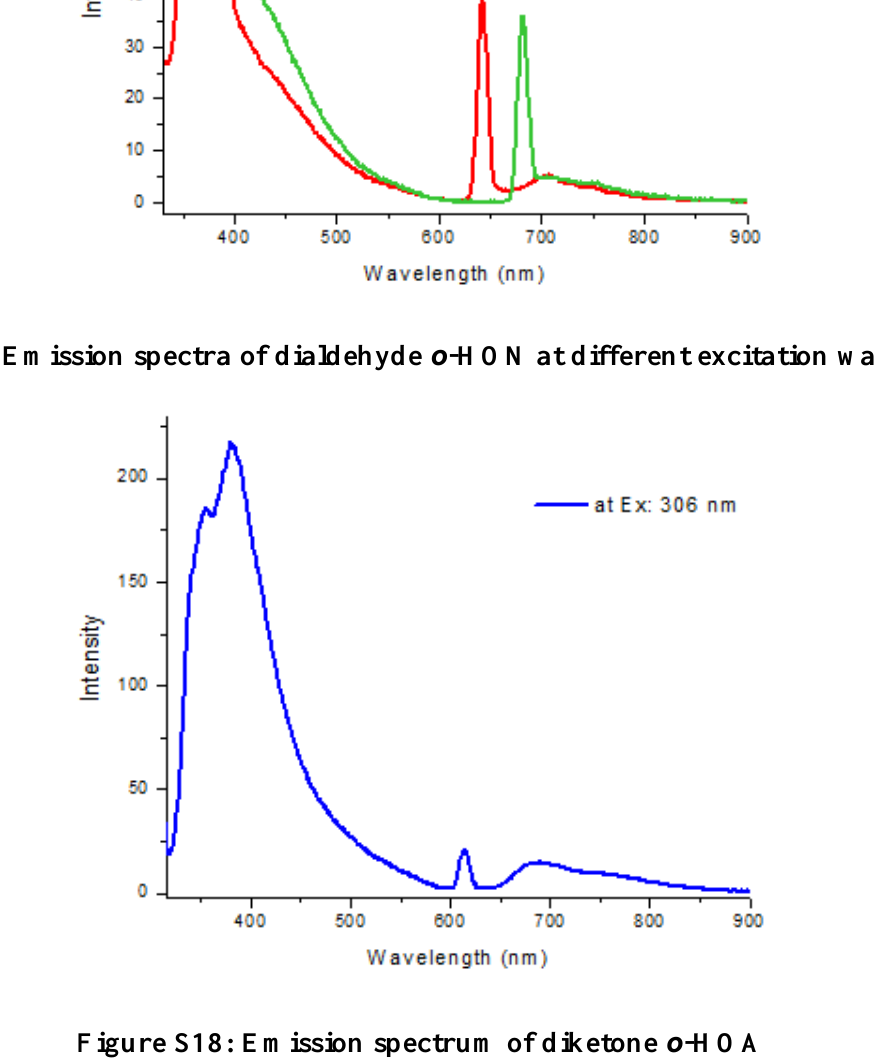
Figure S18: Emission spectrum of diketone o